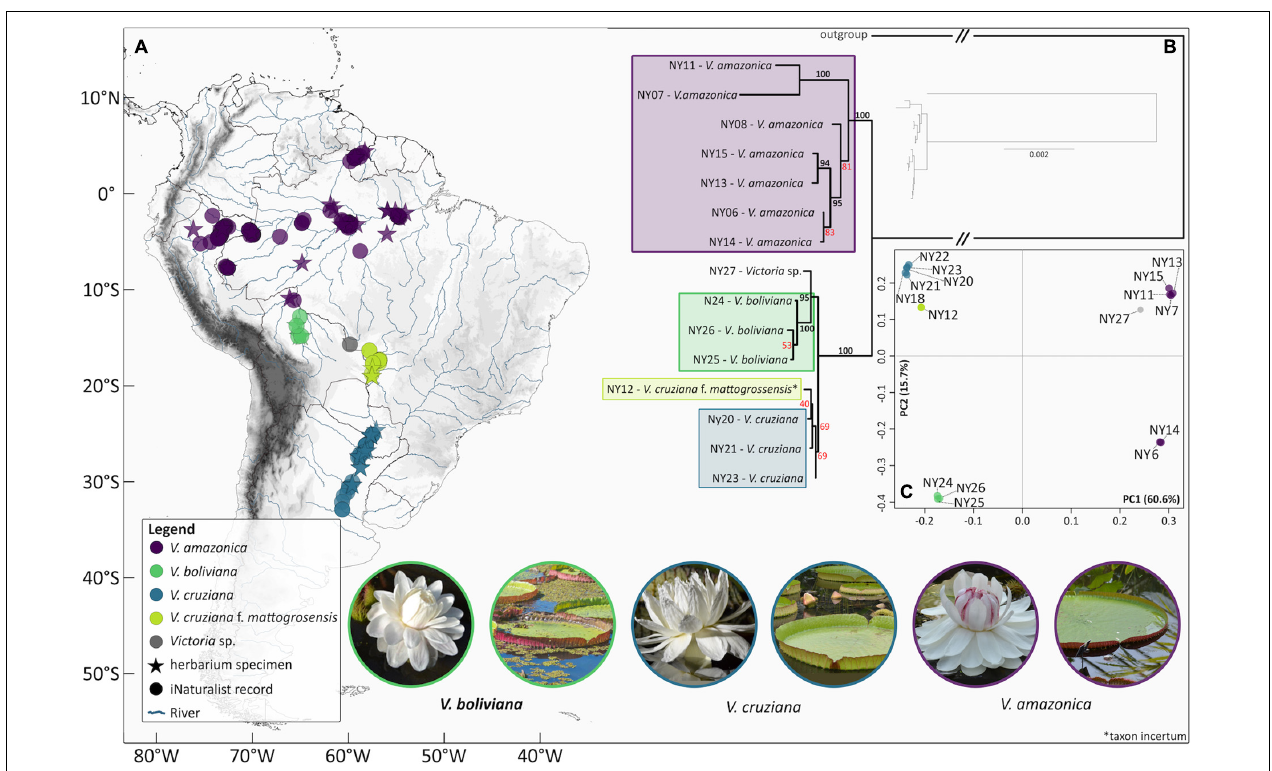
FIGURE 8 | Geographical context with population genomic and phylogenomic results. (A) Geographical coordinates of all Victoria samples used in analyses, where symbols are color-coded according to morphotype/species and symbol type denotes data source. (B) Phylogenomic representation of relationships between plastomes of 15 Victoria samples, with Nymphaea ampla as the outgroup and constructed using RAxML. (C) Principal component analysis of Victoria nuclear dataset in 16 individuals based on 229,281 genotype likelihoods obtained after skimming for a minor allele frequency ( maf ) threshold of